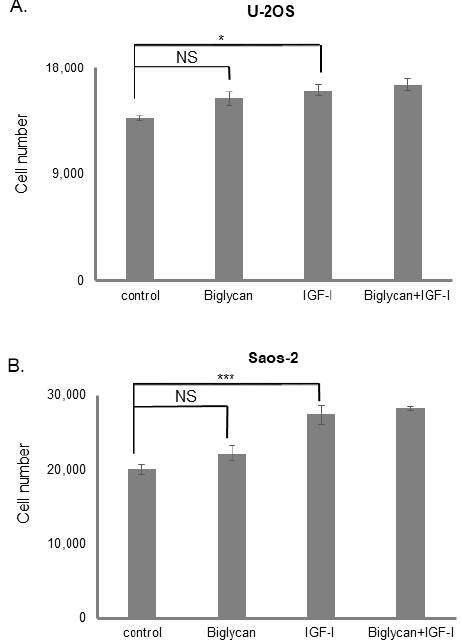
Figure 5. Effect of biglycan and IGF-I on ( A ) U-2OS and ( B ) Saos-2 cells proliferation. Cells were harvested and seeded (4000 cells/well for U-2OS and 20,000 cells/well for Saos-2) on 96-well plates and were allowed to rest overnight. The next day the medium was replaced with 0% FBS DMEM for 24 h. Biglycan treatment was added in 0% FBS medium for the next 48 h at 37 °C and 5% CO 2 . The cells were then lysed, and their number was calculated using the CyQUANT fluorometric assay kit. Results represent the average of three separate experiments. Means ± S.E.M were plotted; statistical significance: * p ≤ 0.05 *** p ≤ 0.001, not statistically significant (NS) compared with the respective control samples.